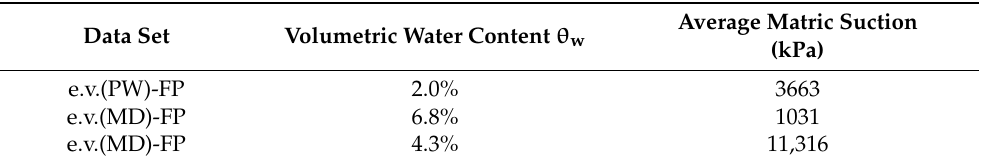
Table 4. Retention data collected through i.c.f.p.m. at the bases of the sample hosted in the experi- mental